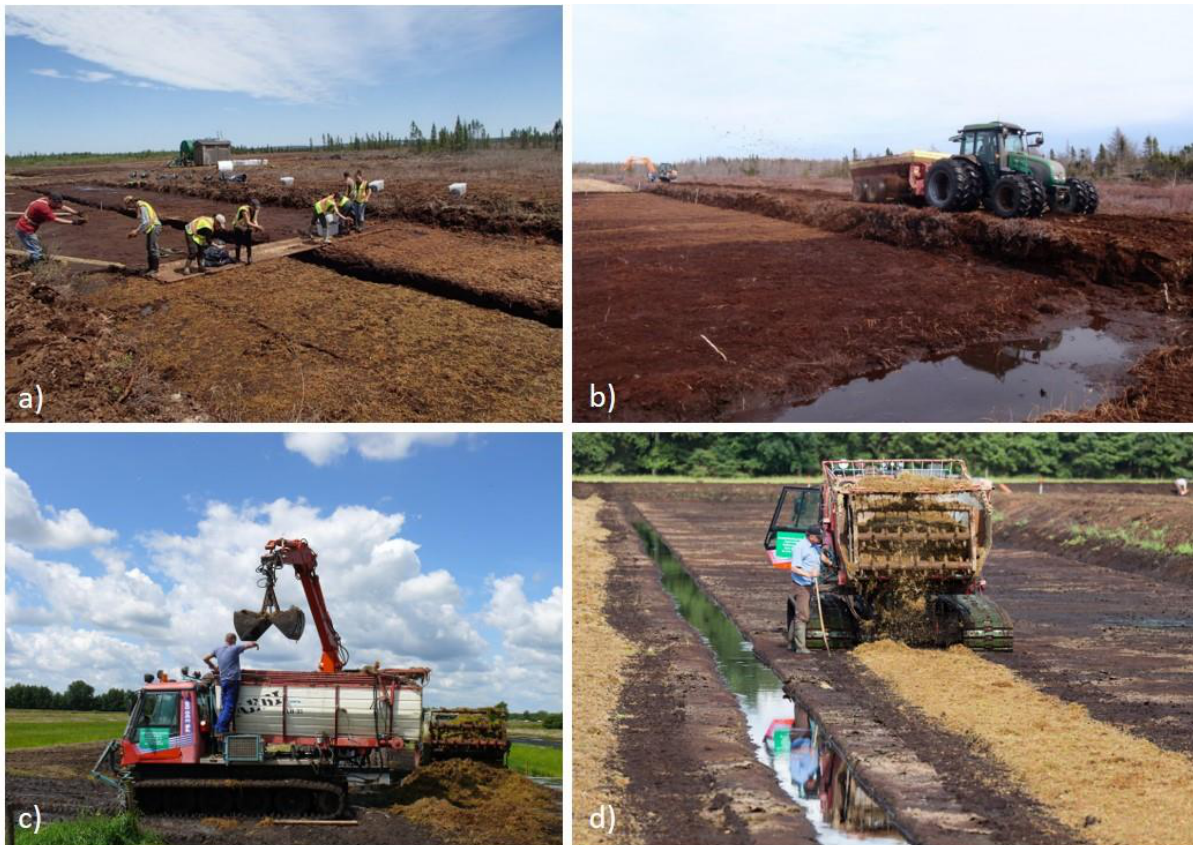
Figure 5. Spreading of Sphagnum and straw mulch: a) manually; b) mechanically by a tractor driving along the edge of the field pulling a manure spreader or a machine that blows the straw onto the site; or by c) loading founder material onto a manure spreader mounted on a tracked vehicle which then d) drives directly on the field. Photos: a) and b) Peatland Ecology Research Group, c) Sabine Wichmann and d)